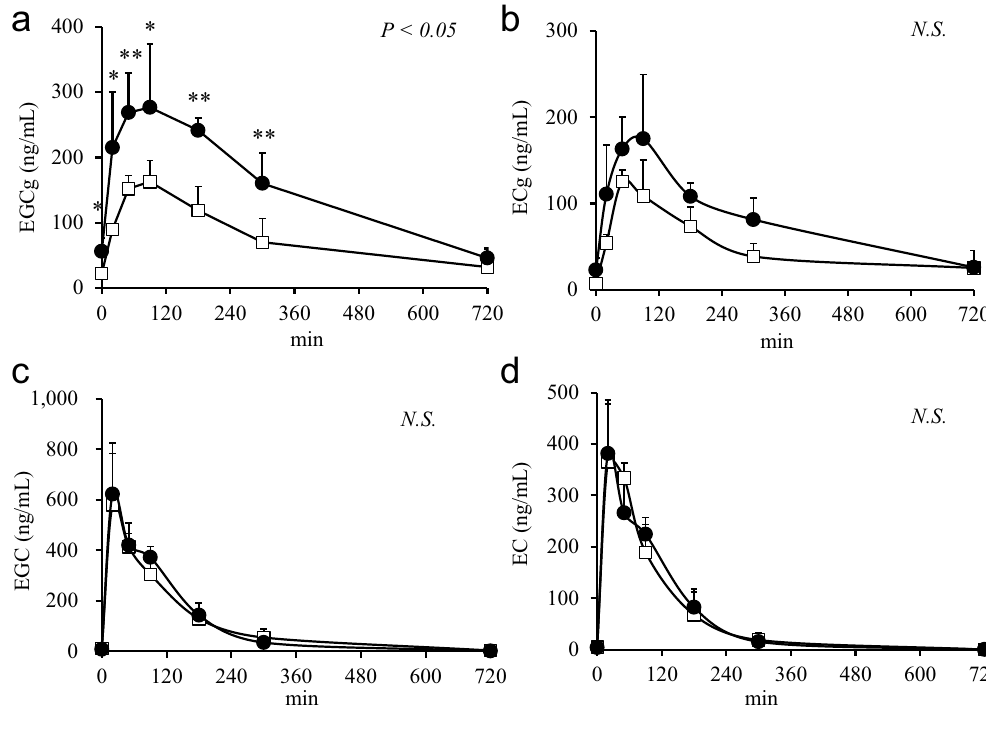
Figure 1. Plasma concentration of ( a ) epigallocatechin gallate (EGCg), ( b ) epicatechin gallate (ECg), ( c ) epigallocatechin (EGC), and ( d ) epicatechin (EC) after oral catechin administration (catechin group, ● ; control group, □ ; n = 5/group). Two-factor repeated measures ANOVA was used to evaluate the group-by- time interaction and the P value for this test is shown in the upper-right of each panel. Data are presented as mean ± SD. Significant differences as determined by Student’s t -test are indicated by * ( P < 0.05) and ** ( P <